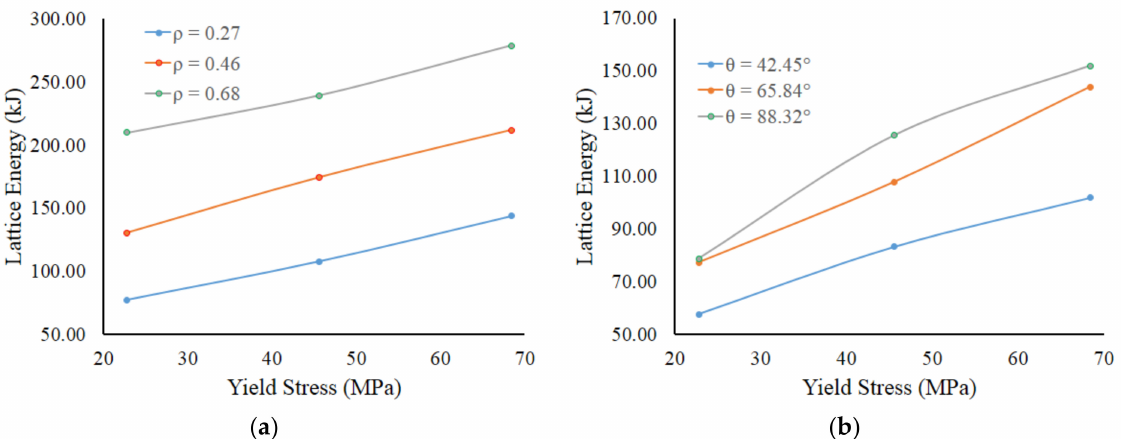
Figure 14. The energy absorption capacity of lattice structure as function of yield strength with parameters: ( a ) relative density at θ = 65.84 ◦ ; ( b ) lattice angle at ρ = 0.27.